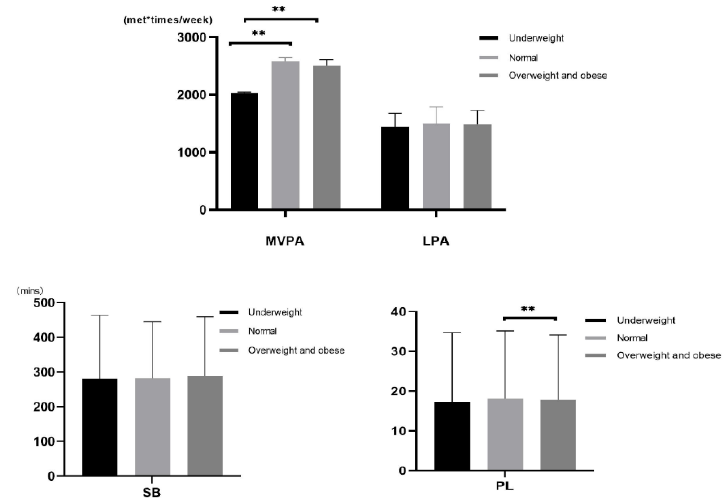
Figure 1. Multiple Comparisons(** p < 0.01).